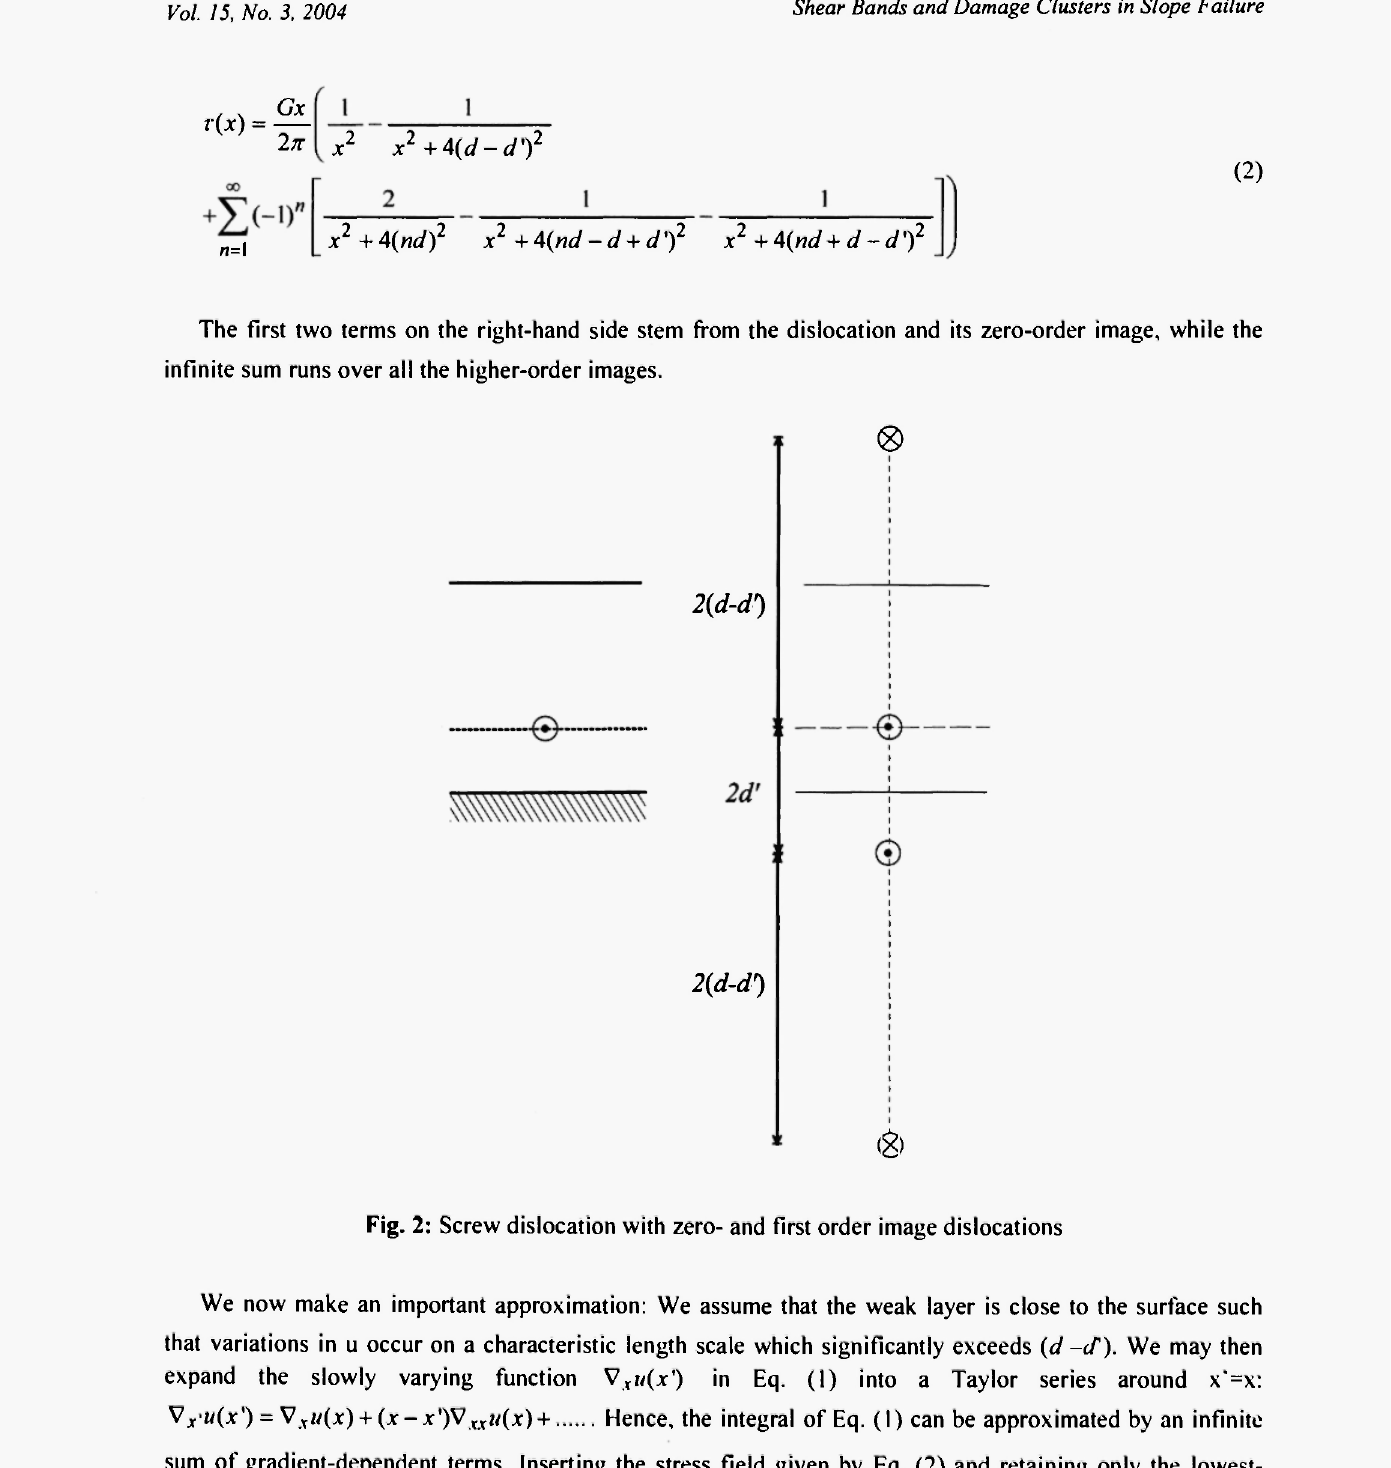
Fig. 2: Screw dislocation with zero- and first order image